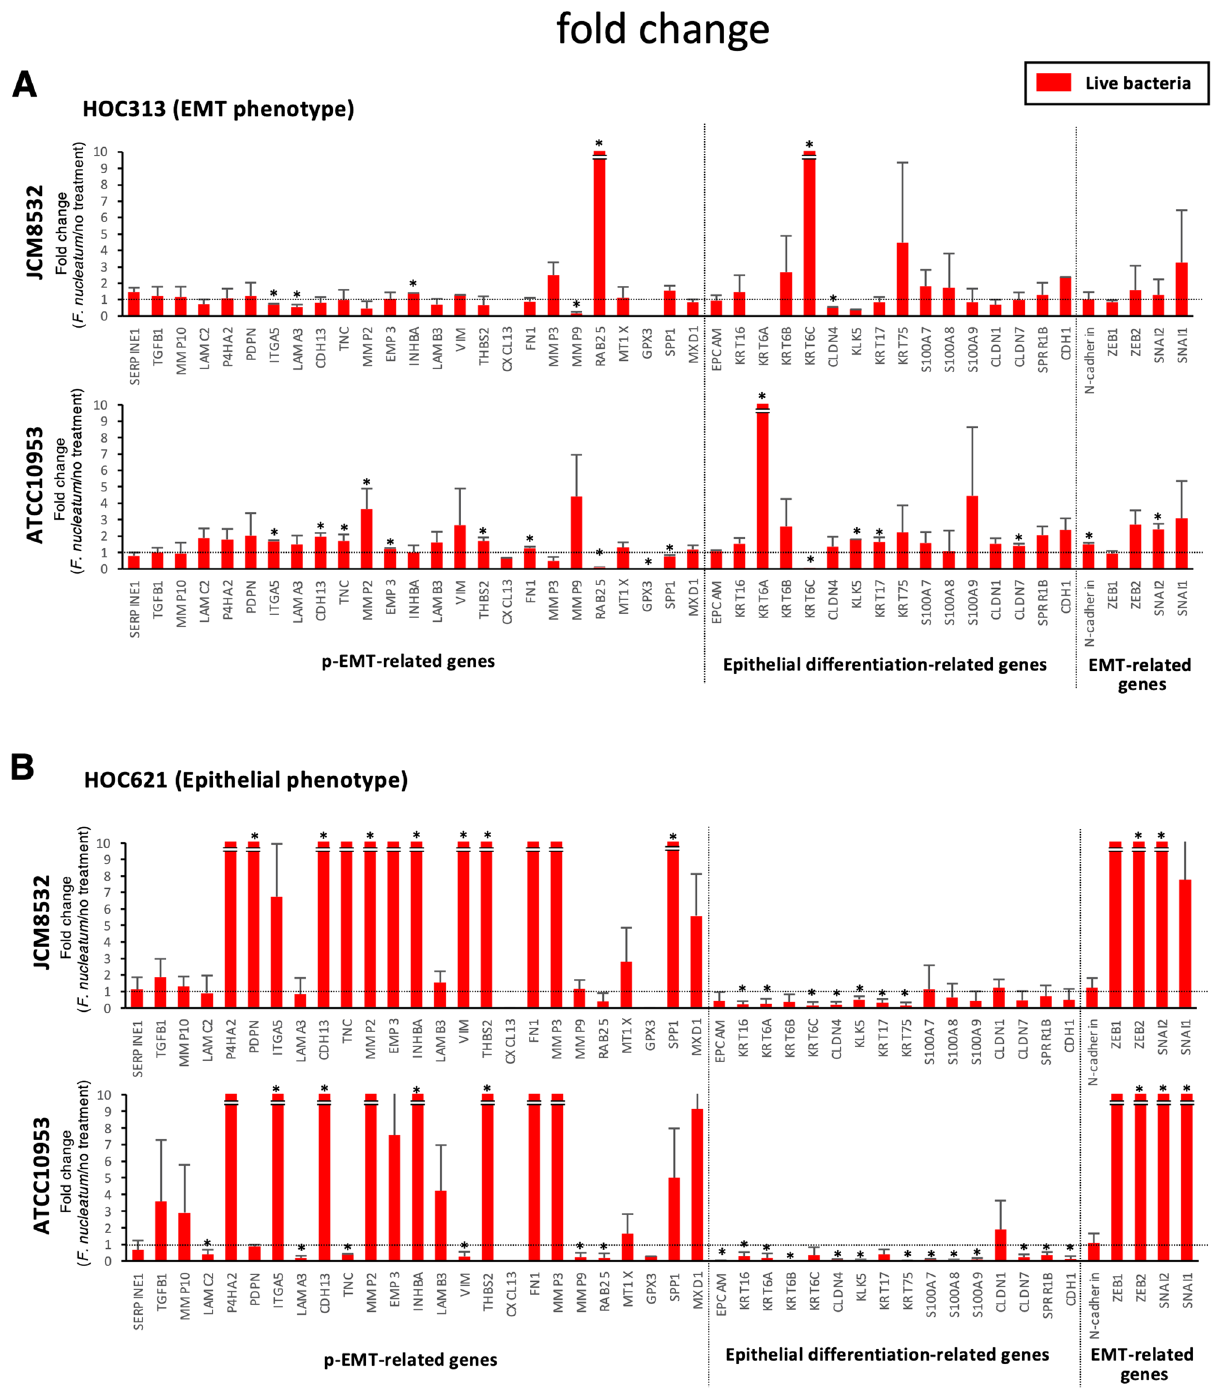
Figure 4. Co-culture with live F. nucleatum upregulates p-EMT-related genes in epithelial phenotype, HOC621 cells, but not in EMT phenotype, HOC313 cells. After co-culture with live F. nucleatum (JCM8532 and ATCC10953, MOI = 10), expression of epithelial differentiation-related, p-EMT-related, and EMT-related genes was determined by qPCR in EMT phenotype, HOC313 ( A ) and epithelial phenotype, HOC621 cells ( B ). The graphs show the results as mean ± S.D. of three independent experiments. (*) represents P -value of < 0.05 compared to control (no